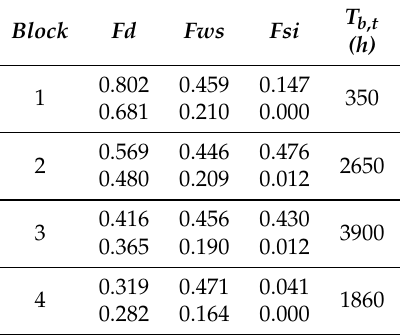
Table 1. Operating